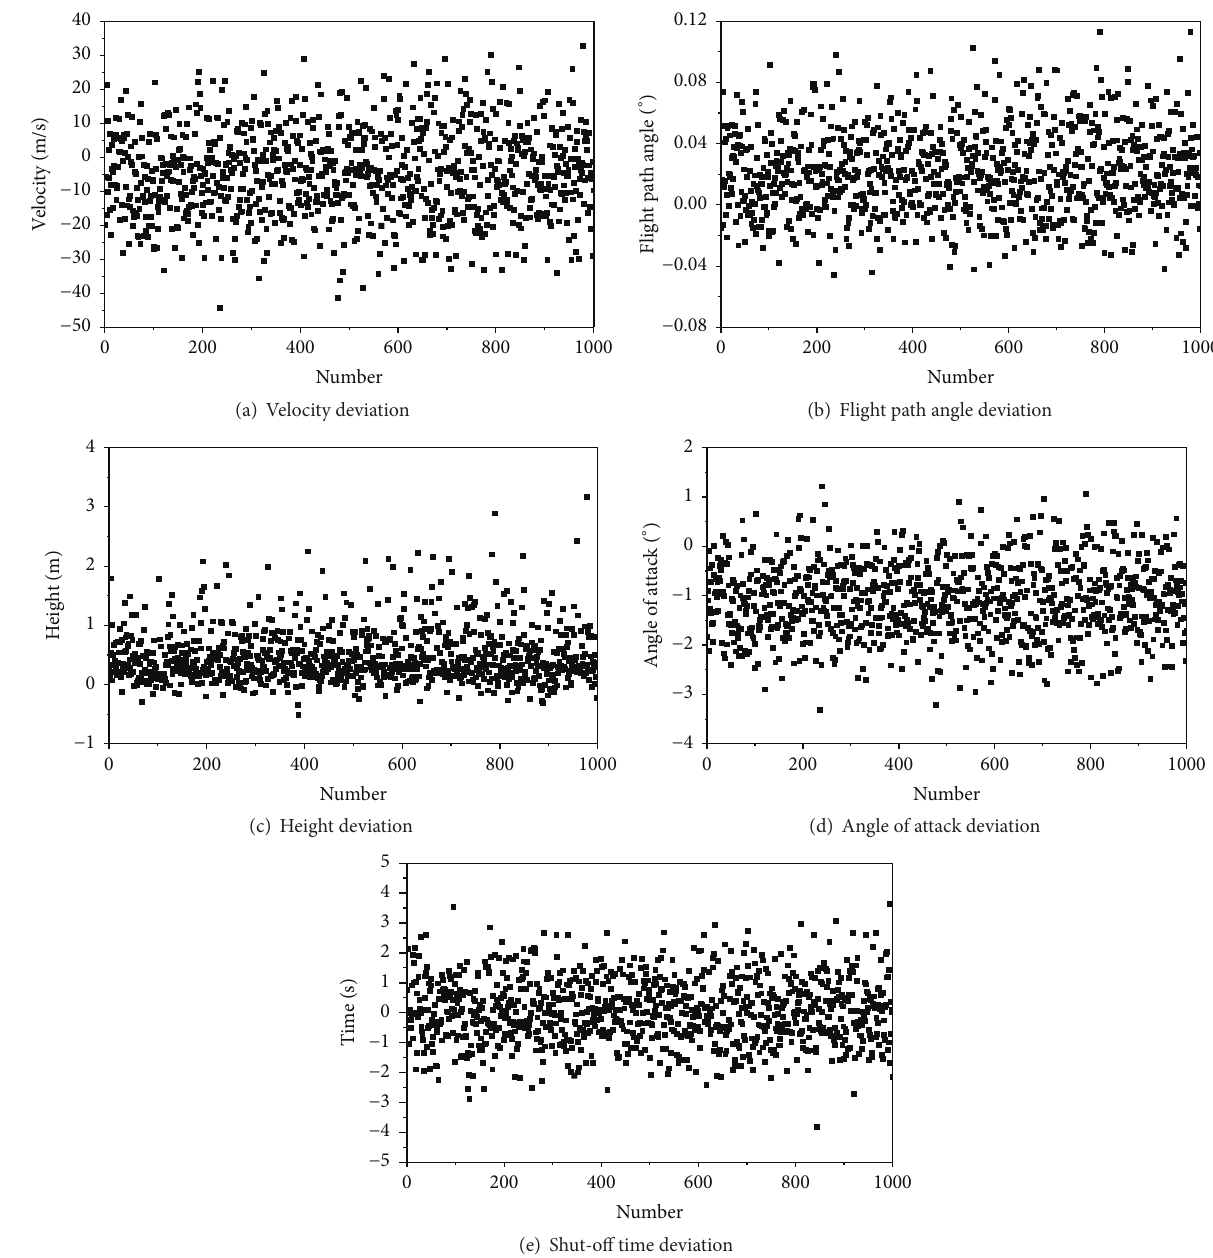
Figure 13: Dispersion of terminal state